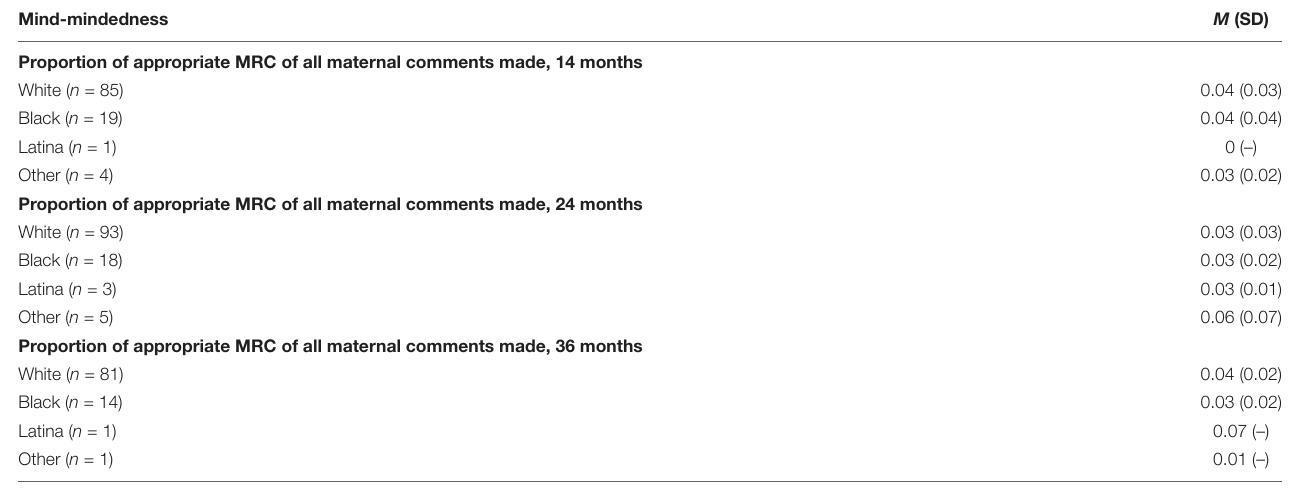
TABLE A1 | Appropriate MRC by Ethnic-Racial